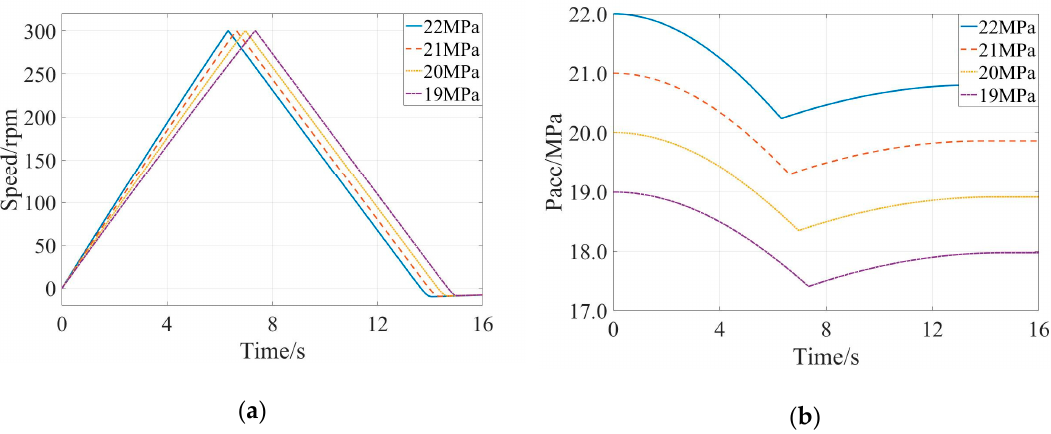
Figure 6. Simulation results with different initial pressure of the accumulator: ( a ) Evolution of speed of the flywheel, ( b ) Evolution of pressure of the accumulator. Table 4. The simulation results in operating mode with different initial pressure of the accumulator.